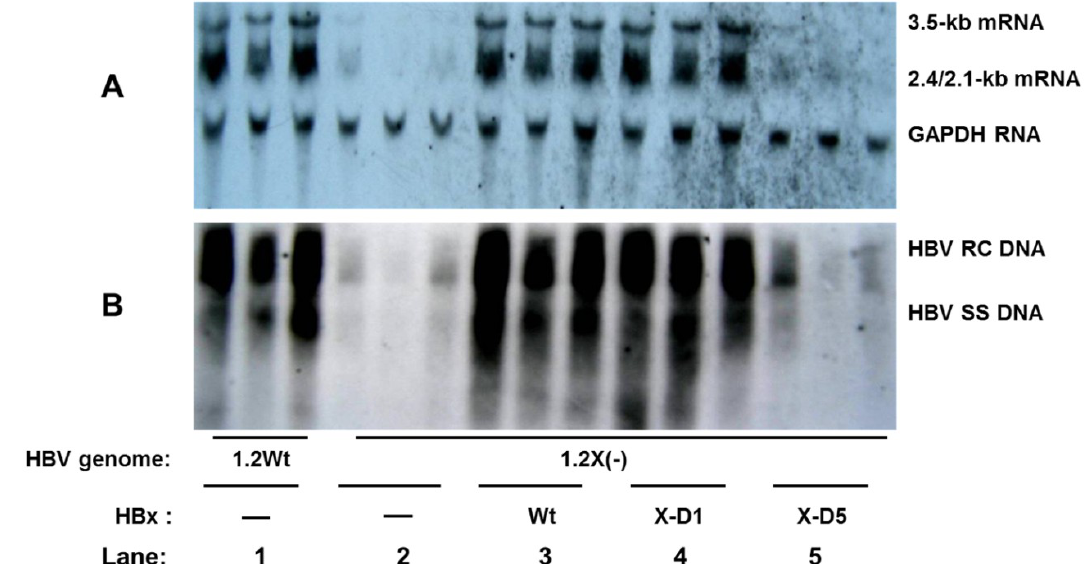
Figure 2. Stimulatory effects of HBx on HBV transcription and replication in vivo . Male BALB/c mice were introduced by hydrodynamic injection with the wild type HBV construct payw1.2 (1.2wt, lane 1) or the HBx-deficient HBV construct payw*7 [1.2X(−), lanes 2 to 5] plus empty vector control (−, lanes 2), full-length HBx expression vector (HBx-wt, lane 3), or different truncated HBx expression vectors (X-D1, lane 4; X-D5, lane 5). ( A ) RNA (Northern) filter hybridization analysis of HBV transcripts. The GAPDH transcript was used as an internal control for RNA loading per lane; ( B ) DNA (Southern) filter hybridization analysis of HBV replication intermediates: HBV RC DNA, HBV relaxed circular DNA; HBV SS DNA, HBV single-stranded